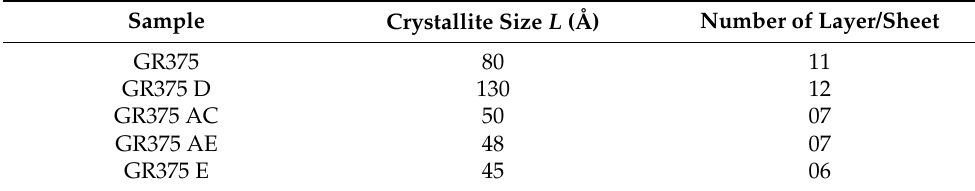
Table 2. Crystallite apparent size and number of